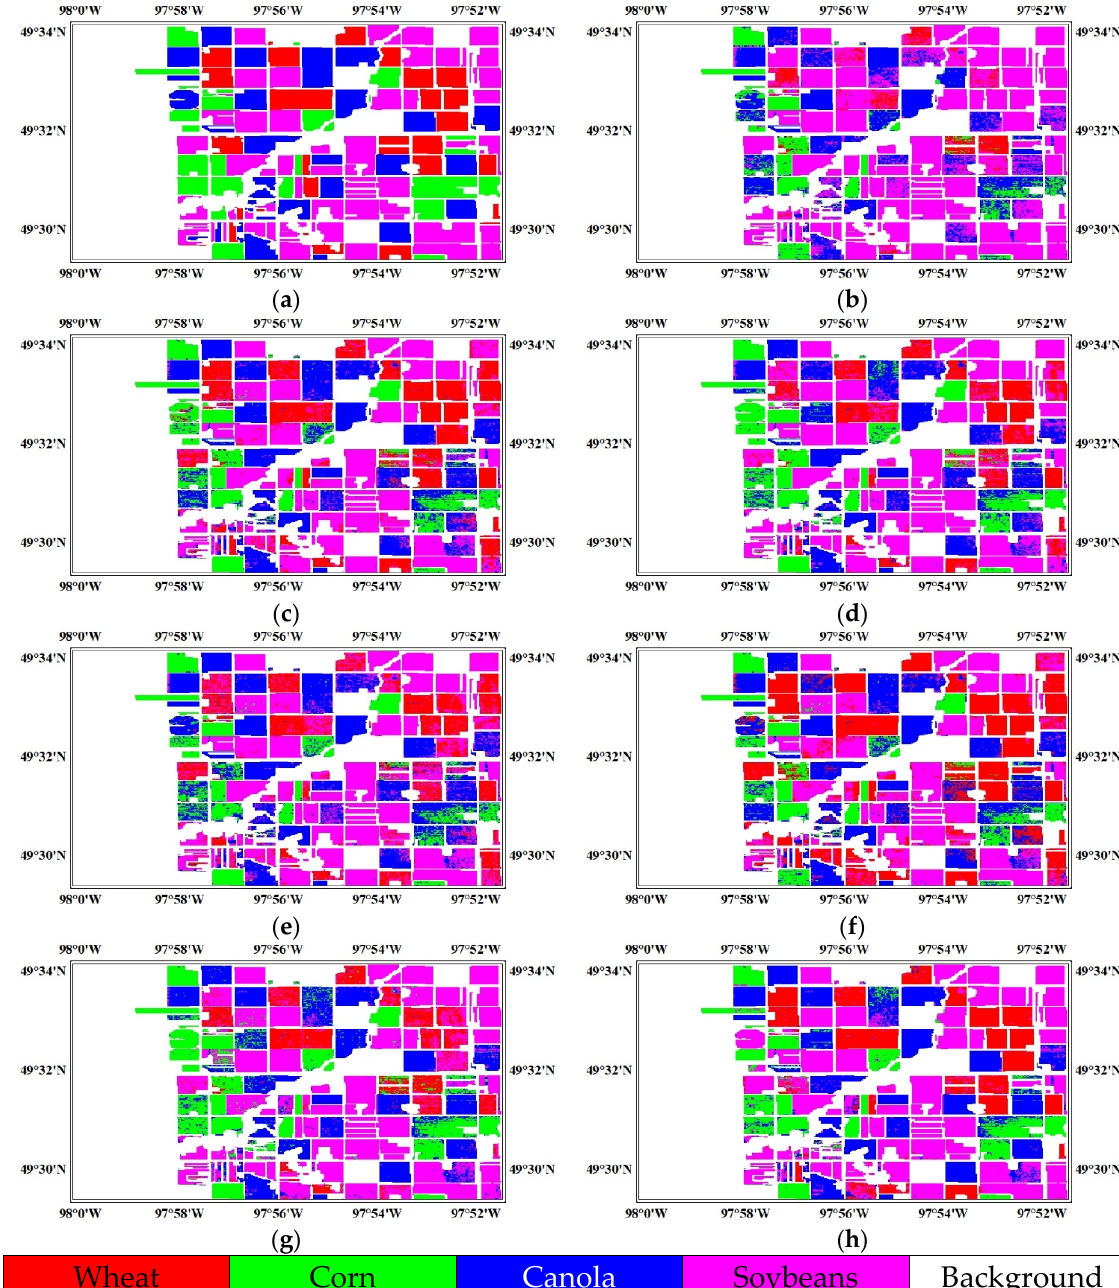
Figure 2. Ground truth map and classification maps in Winnipeg (SD: A -> TD: B), generated by